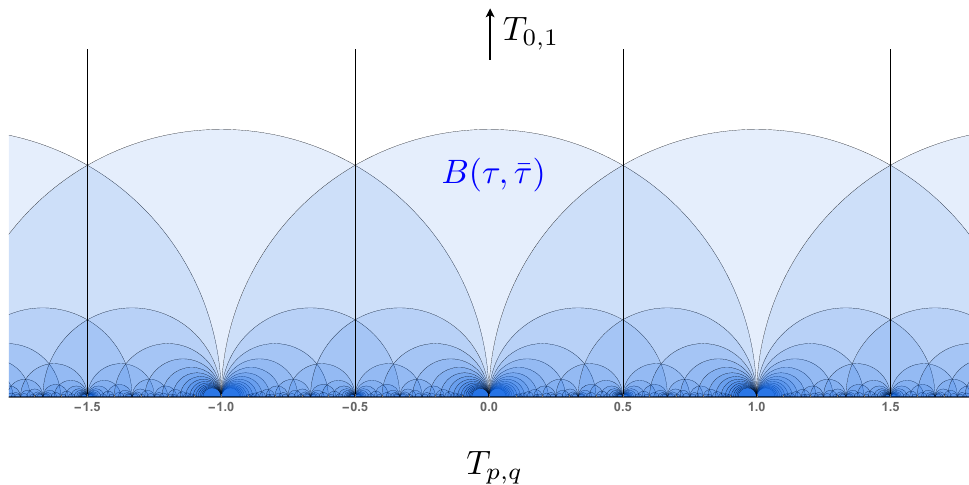
Figure 1 . The family of conformal boundary conditions B ( (cid:28); (cid:22) (cid:28) ) labeled by the variable (cid:28) in the upper-half plane and by a 3d CFT T 0 ; 1 with U(1) global symmetry. At the cusp at in(cid:12)nity the current ^ I a decouples and we are left with the local 3d theory T 0 ; 1 on the boundary, with U(1) current ^ J a . Approaching this cusp from T -translations of the fundamental domain amounts to adding a CS contact term to the 3d theory, or equivalently to rede(cid:12)ne the current ^ J a by multiples of the current ^ I a that is decoupling. This is the T operation on T 0 ; 1 in the sense of [1]. In the favorable situation in which no phase transitions occur, the BCFT continuously interpolate to the cusps at the rational points of the real axis (cid:28) = q=p , where again the bulk and the boundary decouple and we (cid:12)nd new (cid:0) 3d CFTs T p;q . These theories are obtained from T 0 ; 1 with a more general SL(2 ; Z ) transformation, that involves coupling the original U(1) global symmetry to a 3d dynamical gauge